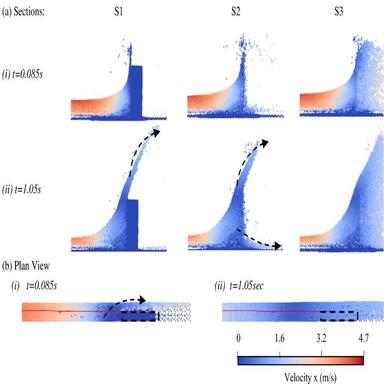
Evolution of impact process (a) at section-cuts S1, S2 and S3 & (b) in plan.